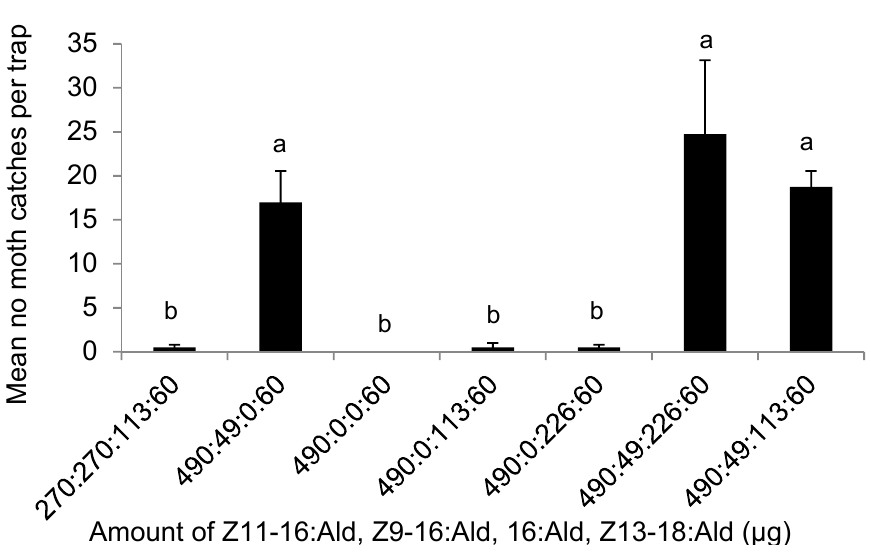
Figure 2. The average number of male Chilo suppressalis caught in the rice fields in Ningbo between 8 August and 20 September 2011 per trap per night, by lures made up of single and mixed blends of the pheromone components Z11-16:Ald, Z9-16:Ald, 16:Ald, and Z13-18:Ald, in the ratios indicated along the x axis. Each treatment was replicated five times. Treatment bars represent the standard errors; bars with different letters above them are significantly different from each other in the number of male moths captured ( p <0.05).